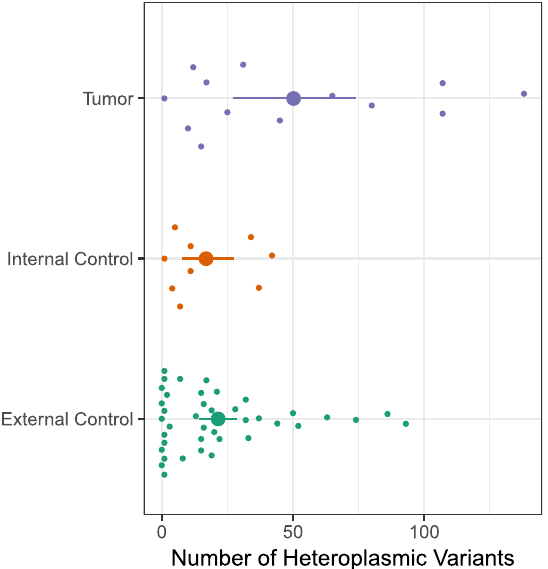
Figure 3. Distribution of heteroplasmic variants in the studied groups: tumor, internal control and external control. Each small dot represents the mean of heteroplasmic variants of a sample. The average number of heteroplasmic variants is also represented for each